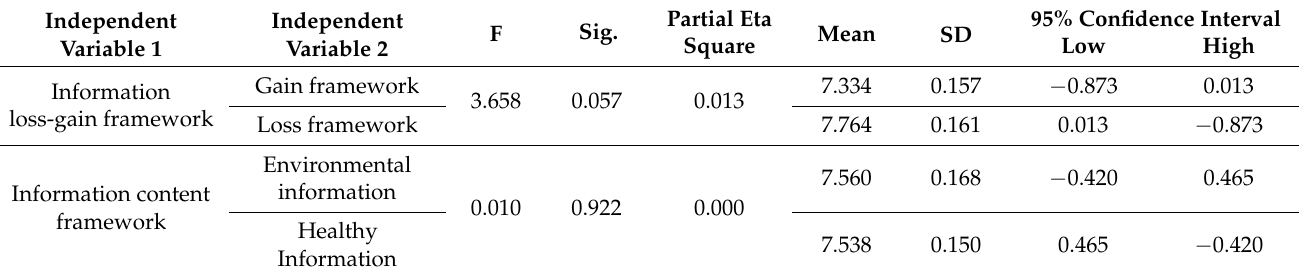
Table 7. Main effects